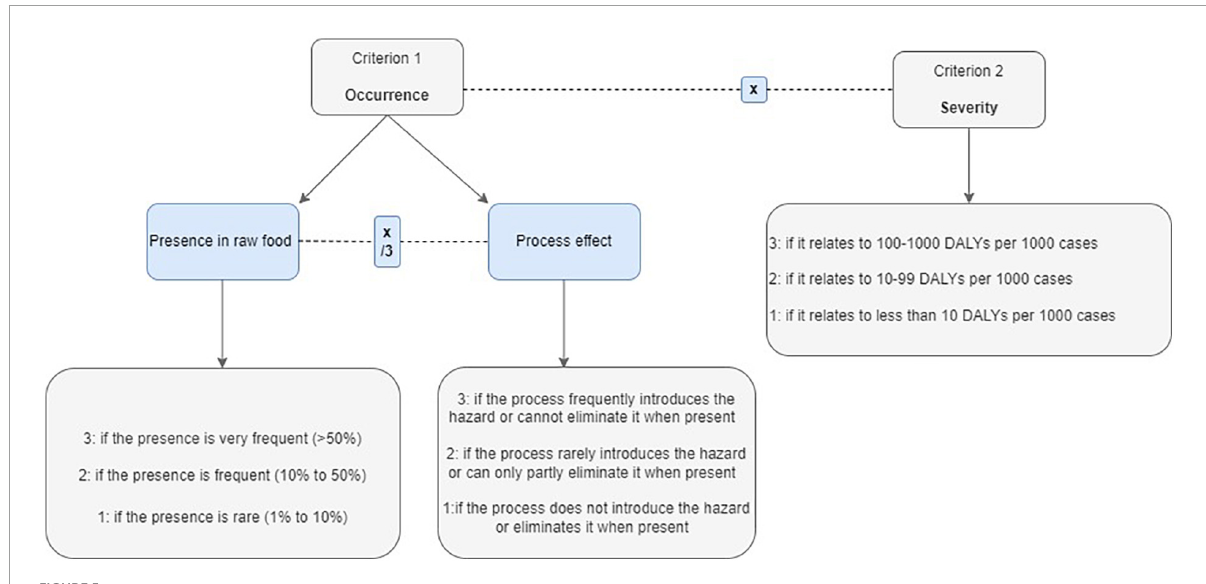
FIGURE5 Definition of sub-criteria of occurrence and severity considered in